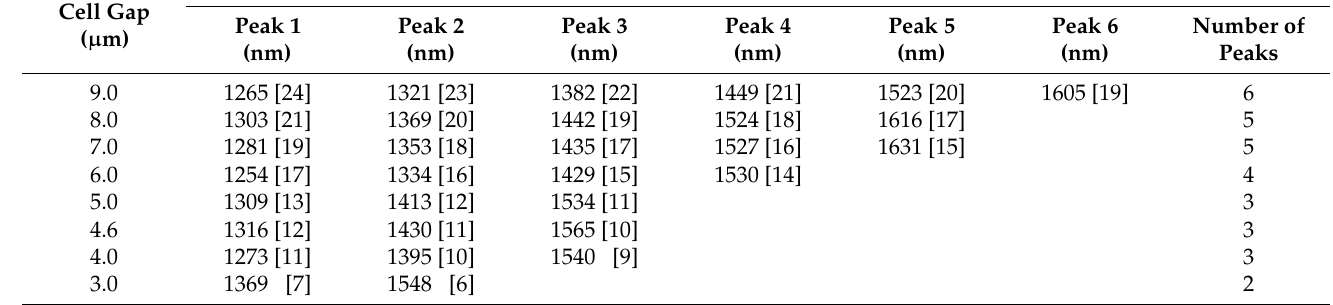
Table 1. Spectral features of defect modes through simulation for a range of PC/LC cell thicknesses in the field-off state. The figure in brackets labels the order of an e -mode